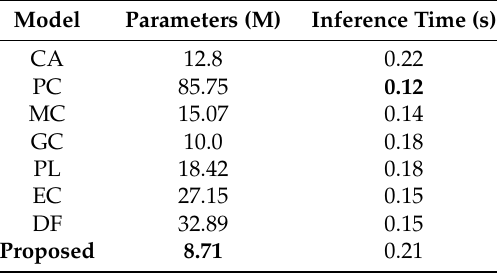
Table 4. Comparison of the number of trainable parameters and model inference